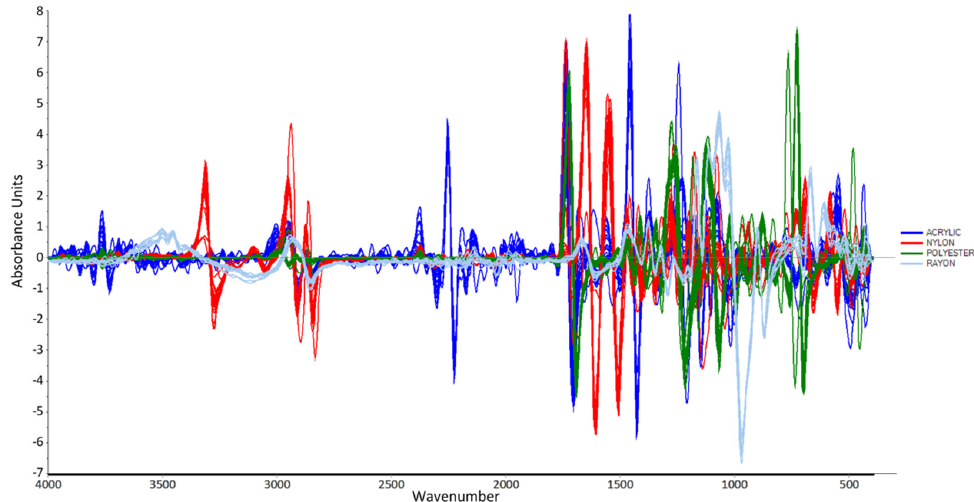
Figure 3. Calibration plot after performing Savitzky-Golay first derivative preprocessing technique.